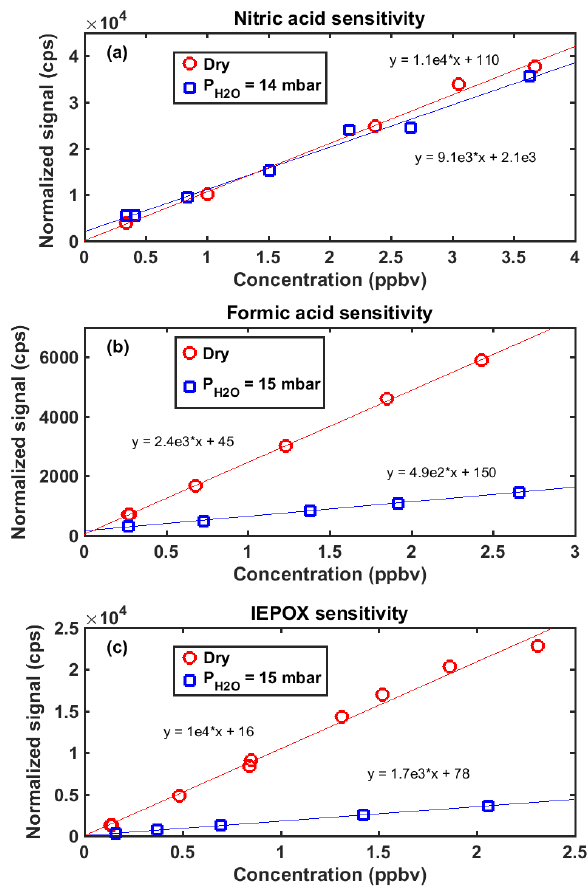
Figure 5. The sensitivity to (a) nitric acid, (b) formic acid, and (c) IEPOX under dry and humid (14 or 15mbar water vapor pres- sure) conditions. Signals are normalized by the ratio of observed total reagent ion count rates to a million ion count rate. The normal- ized signals were observed to be a linear function of the delivered concentration. The slope derived from a linear fit corresponds to the sensitivity per million reagent ion count rates.